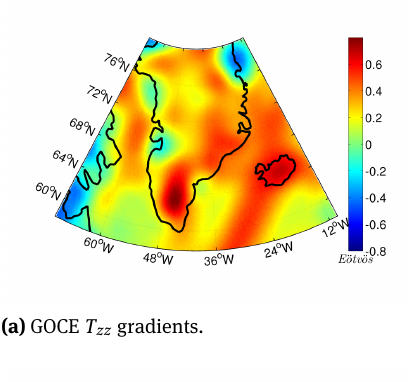
(a) GOCE T zz gradients.